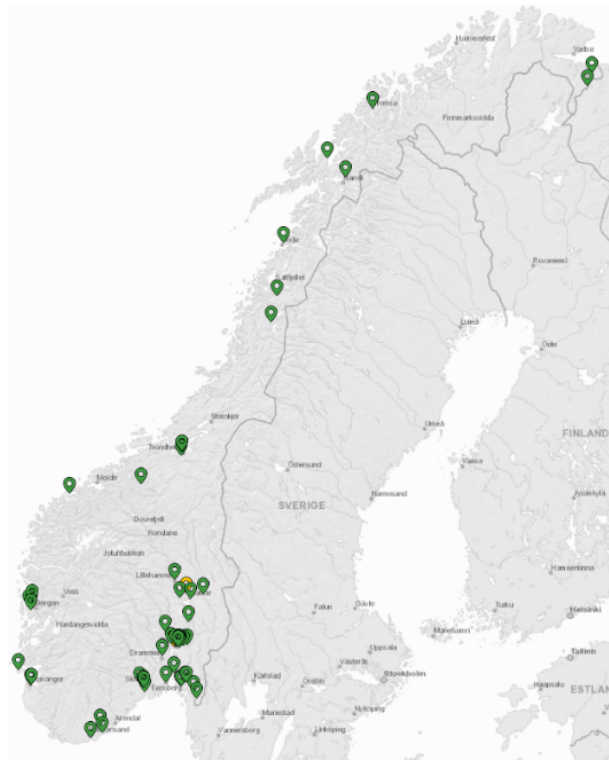
Figure 8. Positions of all 72 monitoring stations in Norway: 33 for PM 2 . 5 , 36 for NO 2 , 45 for PM 10 and 8 for O 3 (© kartver-